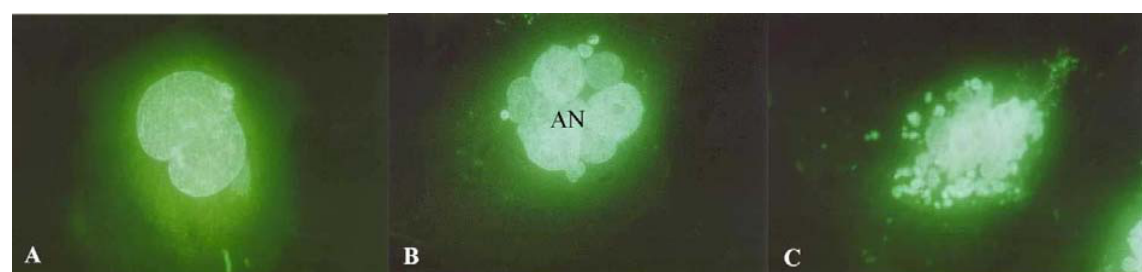
Figure 3: Visualization of nucleus of CHO-K1 cells after C. d. terrificus crude venom treatment. (A) Control cells. (B) Cells treated with 10 μ g/ml of C. d. terrificus crude venom for 1 hour. Apoptotic nucleus (AN). (C) Cells treated with 100 μ g/ml of crude venom for 24 hours. Chromatin condensation and nucleus fragmentation. X 2,500.